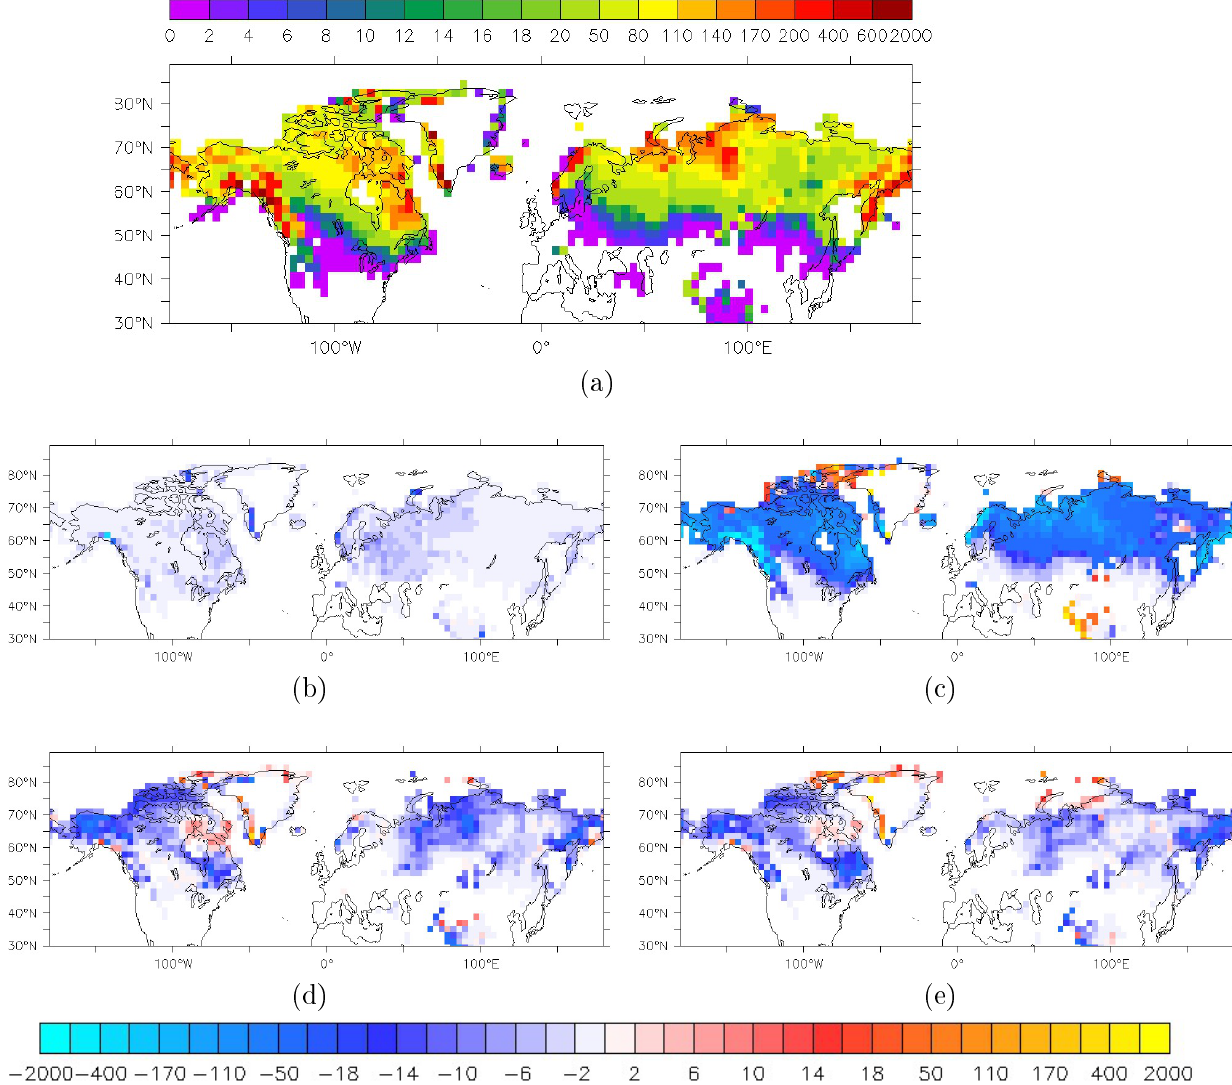
Fig. 6. Spring (April–May–June) average of snow depth (SWE, mm): (a) present-day SWE, S1; (b) present-day SWE difference induced by BC deposition on snow (S1–S1B), (c) difference between 2050 RCP8.5 scenario and present-day SWE (S2–S1); (d) SWE